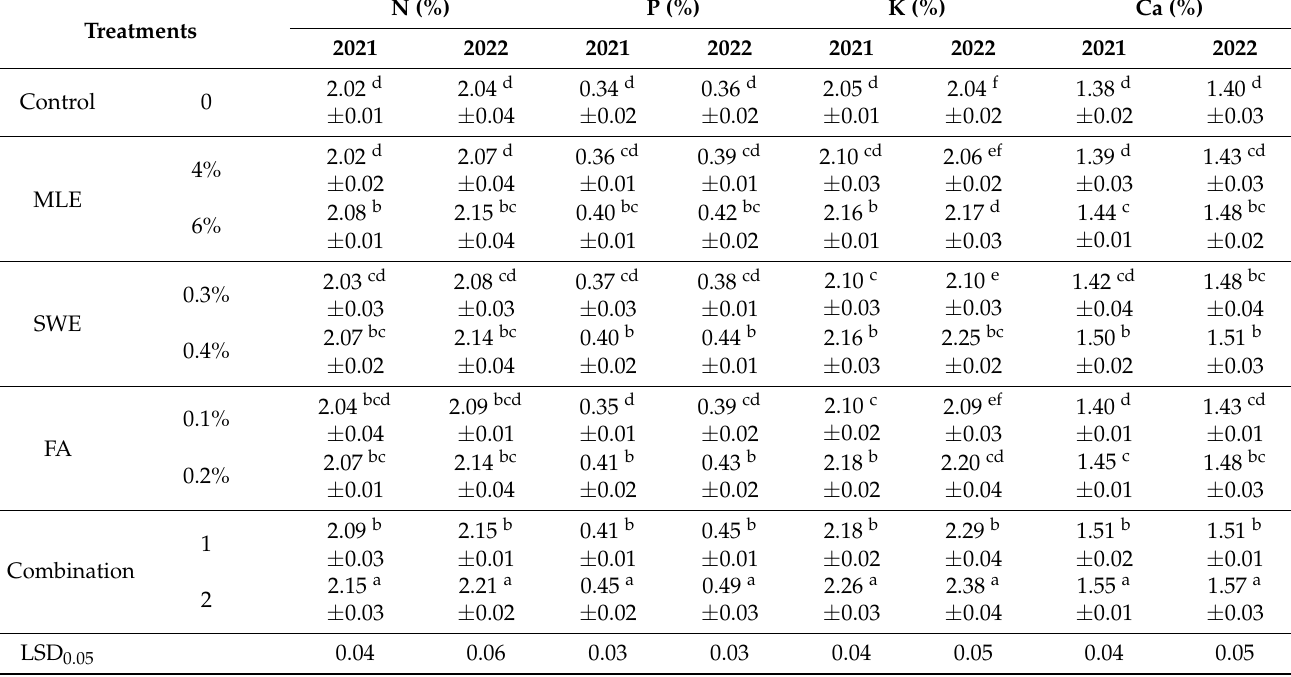
Table 7. The influence of the spraying of MLE, SWE and FA and their combinations on leaf N, P, K and Ca contents of apple cv. Anna during 2021 and 2022.